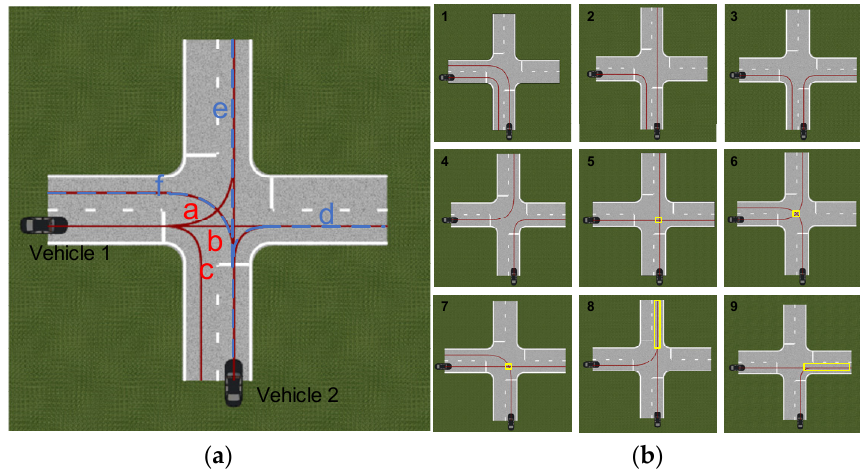
Figure 1. The relationship between two vehicles when passing through the intersection: ( a ) the pos- sible driving directions of vehicle and ( b ) collision area under different conditions.